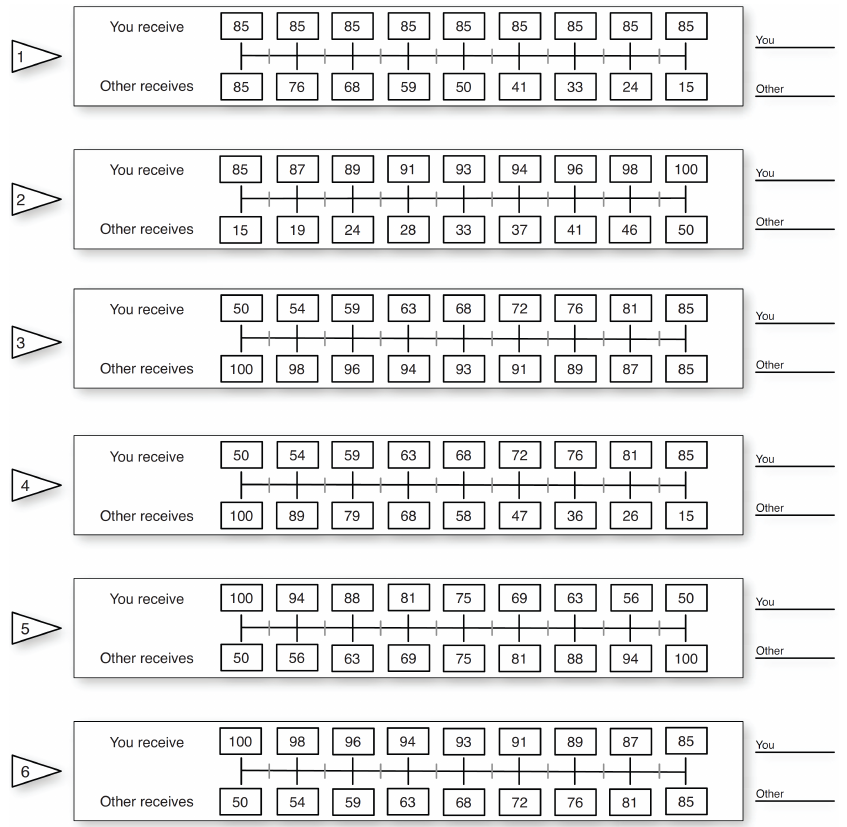
Figure A1. Slider questions to measure Social Value Orientation as seen by